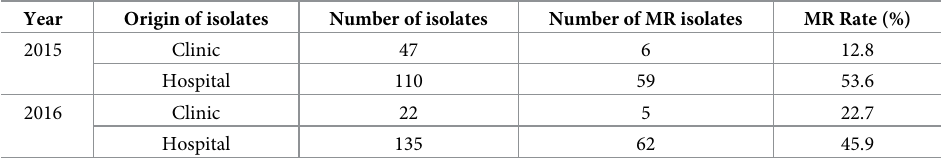
Table 2. Differences in the rate of macrolide resistance of M . pneumoniae isolates between clinics and